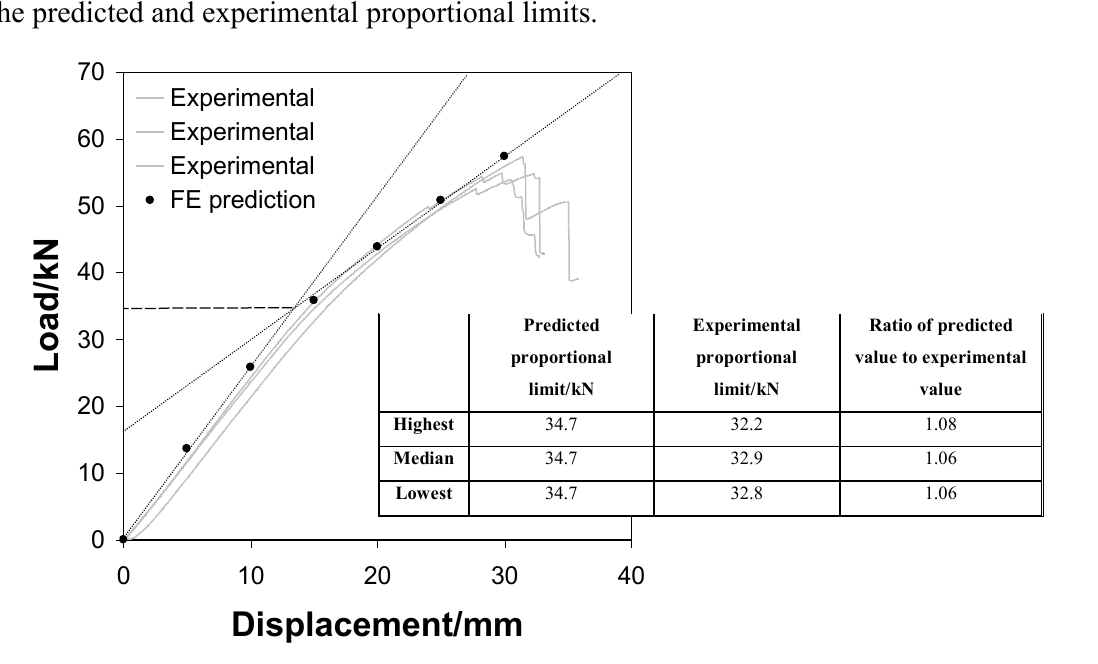
Figure 9. Load-displacement curves for series II tested steel-reinforced LVL samples (in grey) and estimated finite element predictions (black dots). A comparison is made between the predicted and experimental proportional